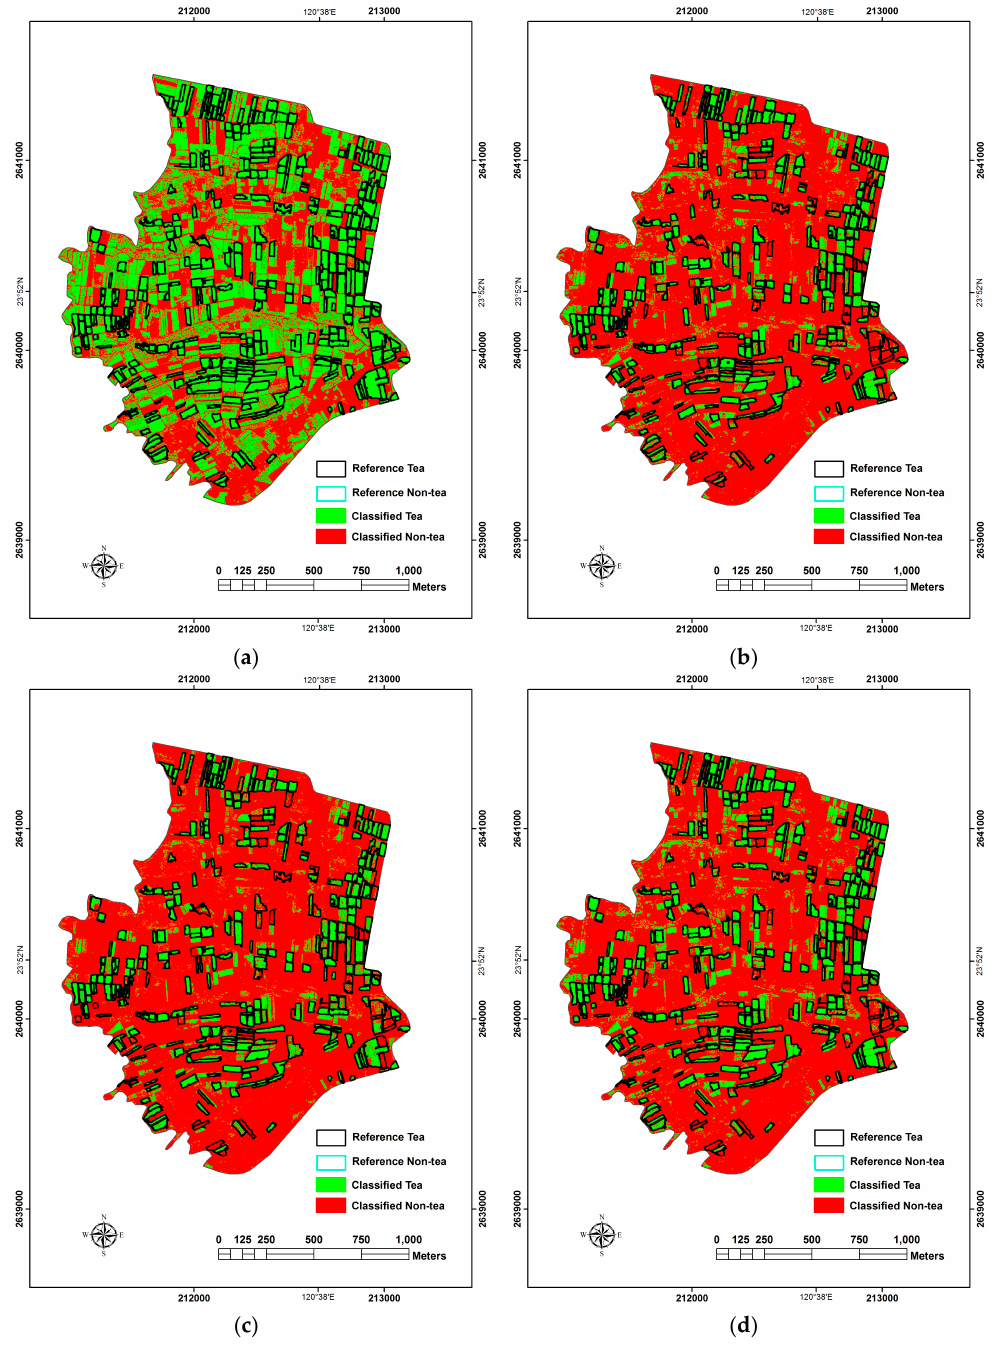
Figure 6. The results of PBIA classification. ( a ) ML; ( b ) LR; ( c ) RF; ( d ) SVM.